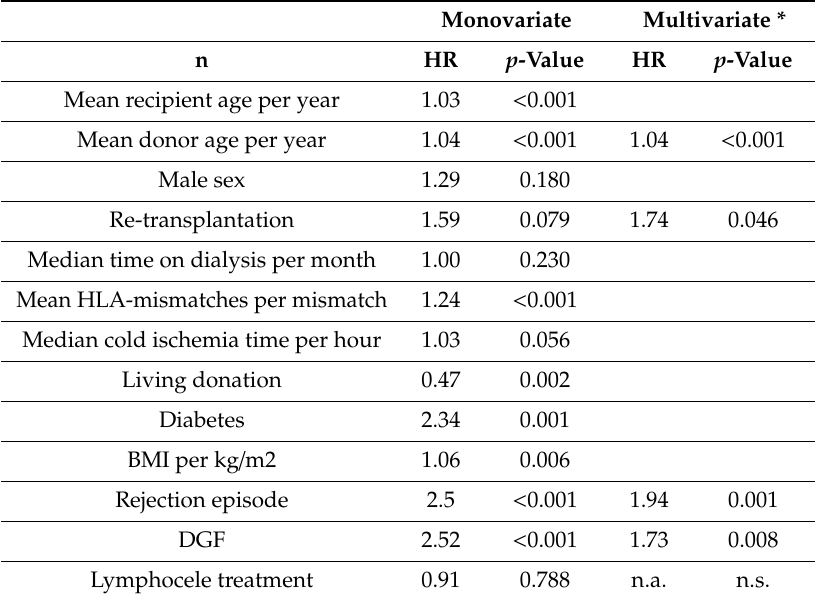
Table 3. Risk factor analysis for graft loss using a Cox proportional hazard